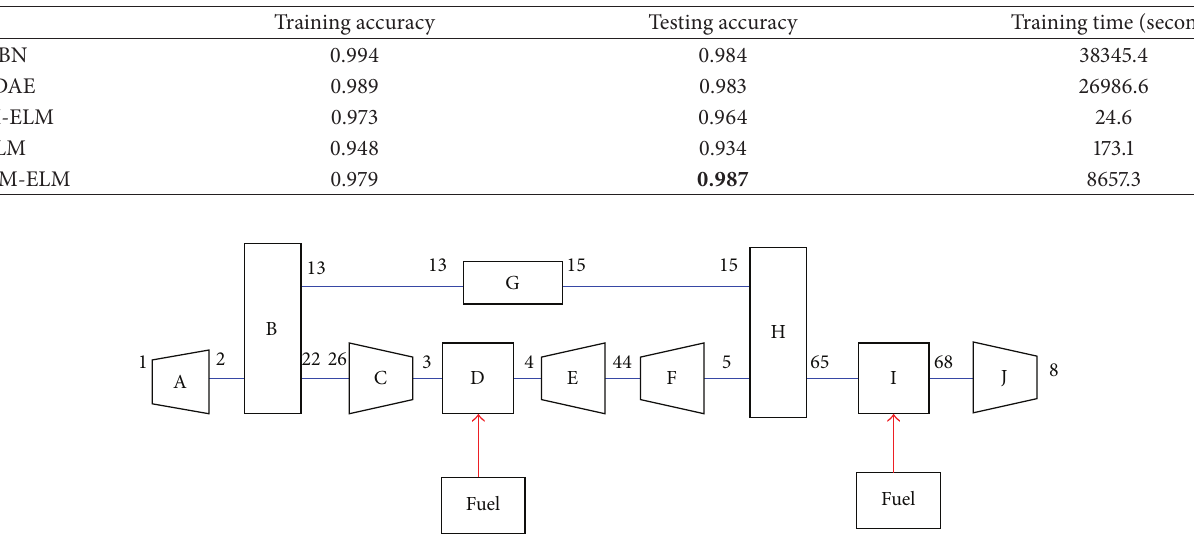
Figure 4: Schematic layout of studied turbine fan engine. A, inlet; B, fan; C, high pressure compressor; D, main combustor; E, high pressure turbine; F, low pressure turbine; G, external duct; H, mixer; I, afterburner; J, nozzle.